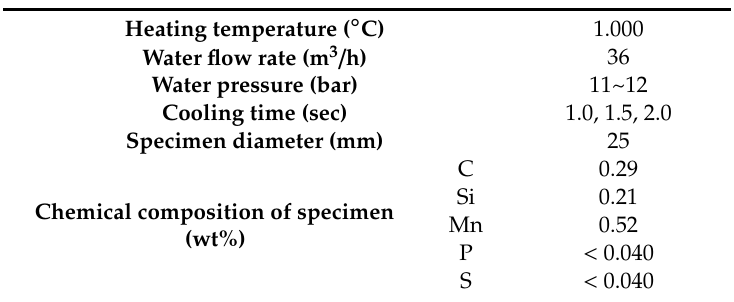
Table 3. Performance test with respect to cooling time.